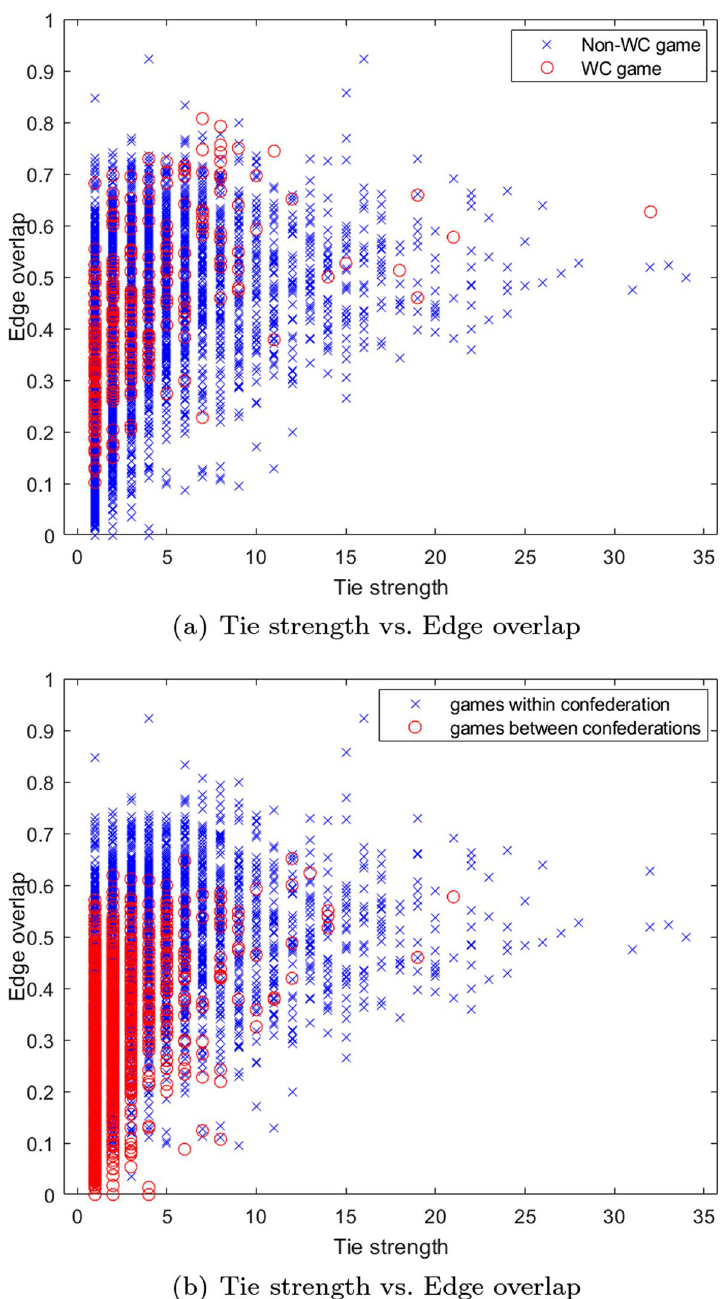
Fig. 4 Tie strength versus Edge overlap. Each point (circle/cross) corresponds to an edge with its tie strength as x-axis value and edge overlap as y-axis value. a World Cup (WC) games are marked as red circles and others are marked as blue crosses. Red circles gather in the lower left corner, indicating that most edges of World Cup games have low tie strength and low overlap; b Games between countries in different confederations are marked as red circles and games between countries in the same confederation are marked as blue crosses. Red circles gather in the lower left corner, indicating that most edges of games between confederations have low tie strength and low